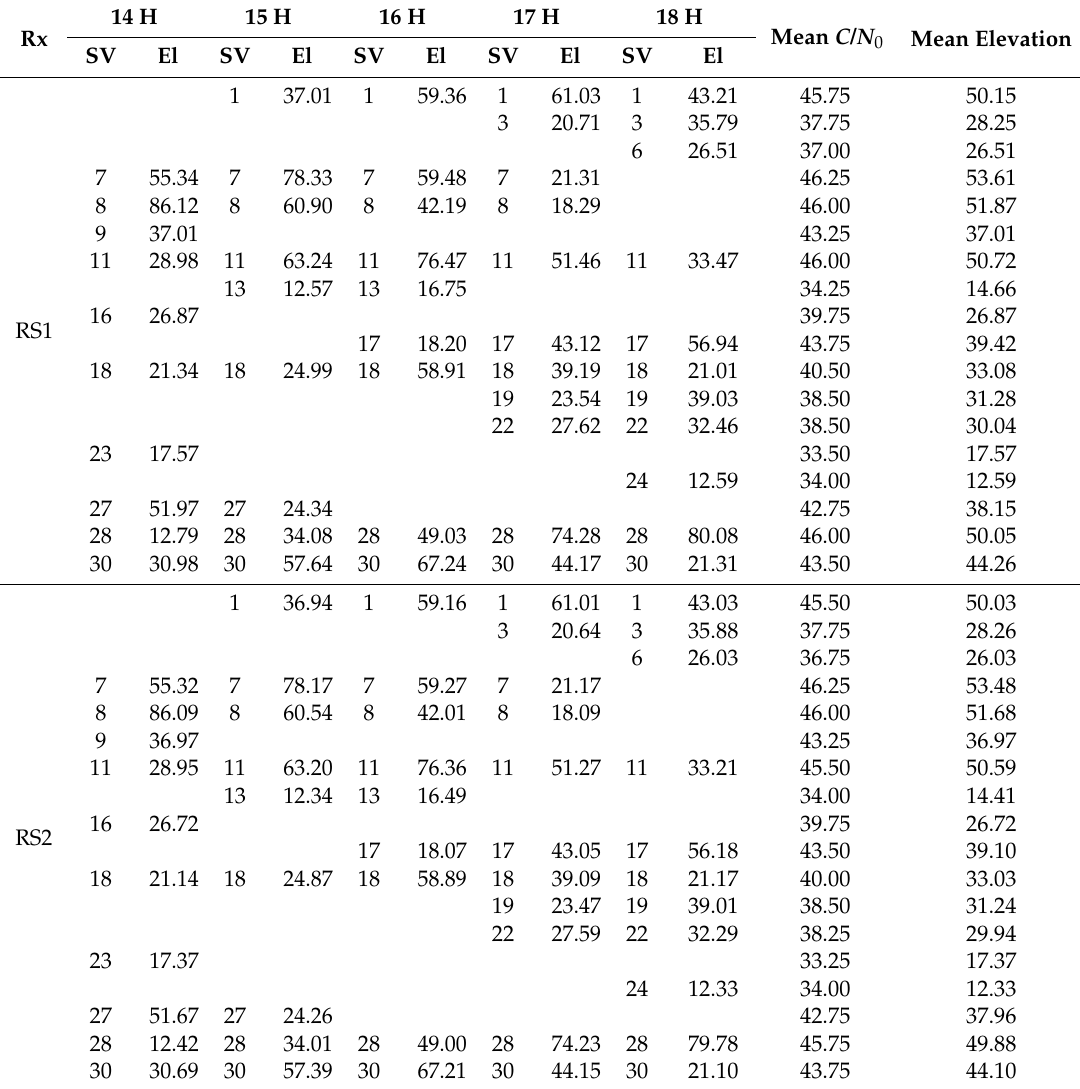
Figure 6. Location of MS in Montreal downtown (GPS antenna placed inside a car). Table 1. Visible satellites during observation period.